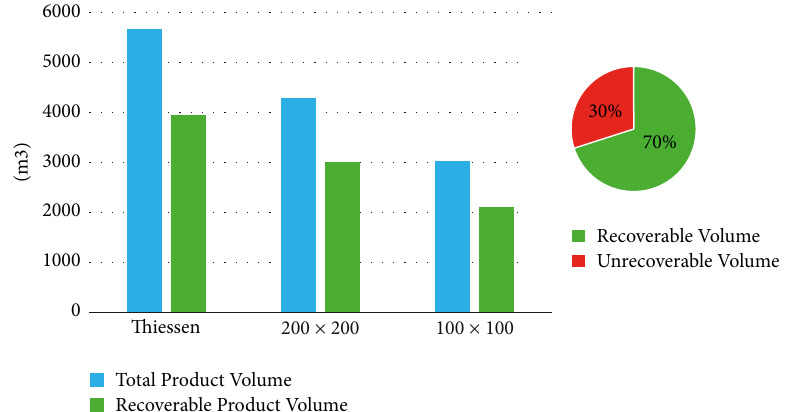
Figure 7: Comparison between total product volume and recoverable product volume of June 2013, estimated through the Vertical Equi- librium Model. The pie chart shows the recoverable volume and the unrecoverable volume through the pumping, according to the Vertical Equilibrium